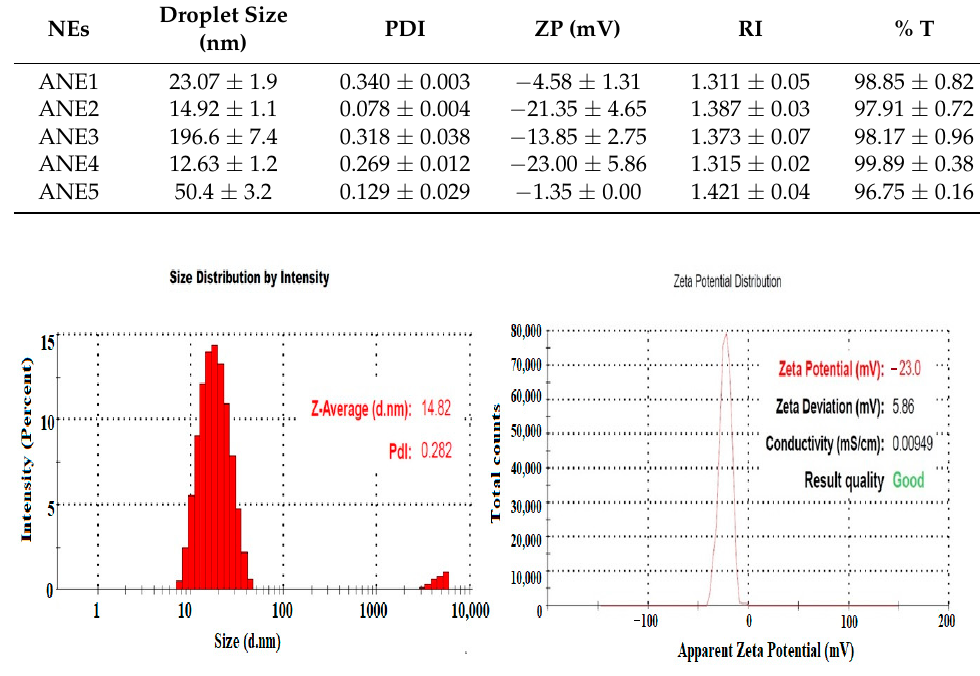
Figure 3. Mean droplet size and zeta potential of APL ‐ loaded NE (ANE4). Table 1. Physico ‐ chemical evaluation of APL ‐ loaded NEs (ANE1 ‐ ANE5). NEs